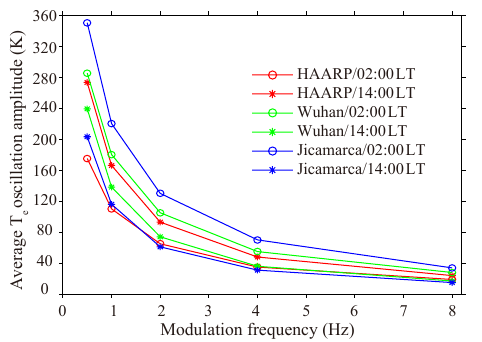
(cid:49)T e spatial distribution across the field does not show ev-